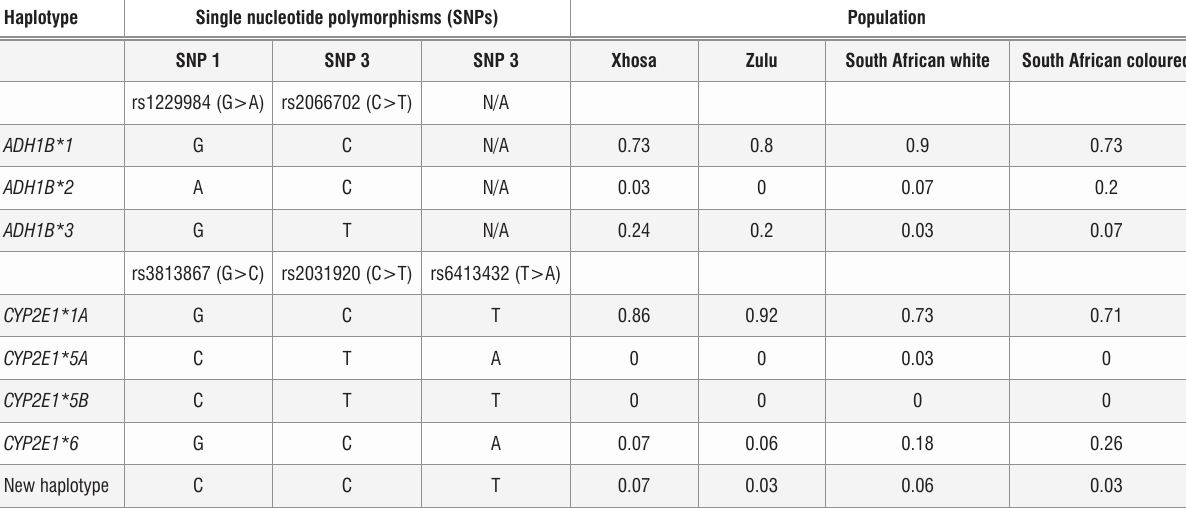
Table 4: Frequencies of ADH1B and CYP2E1 haplotypes in the four South African populations Haplotype Single nucleotide polymorphisms